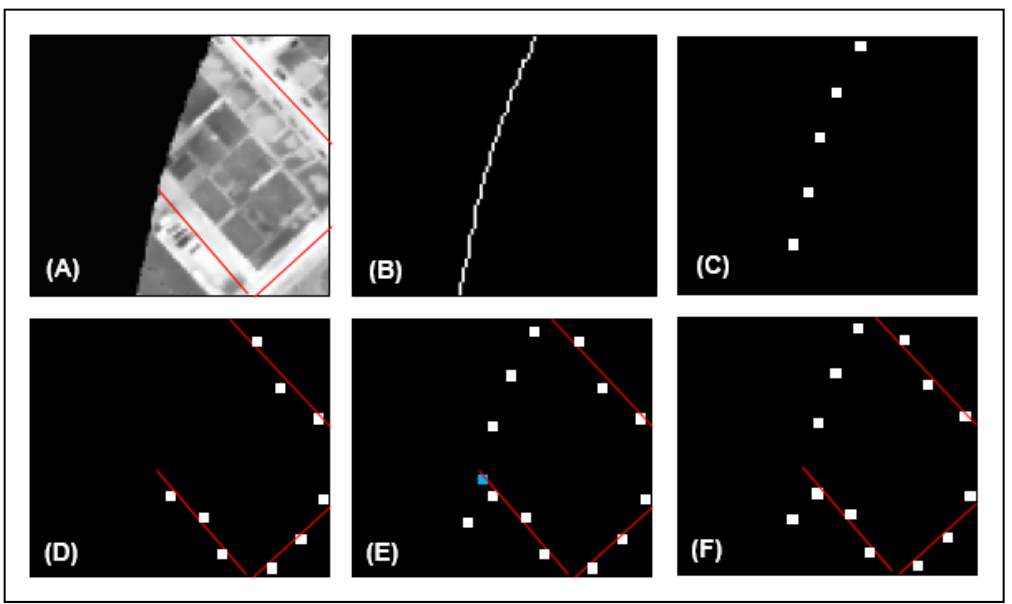
Figure 6. An example of selecting sample points from the image border, then cleaning these points to reduce oversampling. ( A ) A portion of the thermal flight-line (grayscale) showing the acquisition border (black) and Road center line (red). ( B ) A corresponding portion of the border line detected using edge detection. ( C ) Sample points (enlarged for illustration) taken along the border at a 10 m interval. ( D ) Road sample points (white) with the Road center (red). ( E ) Border samples combined with the Road samples. The blue square (lower center) represents a sample location to be cleaned. ( F ) Final sample points after